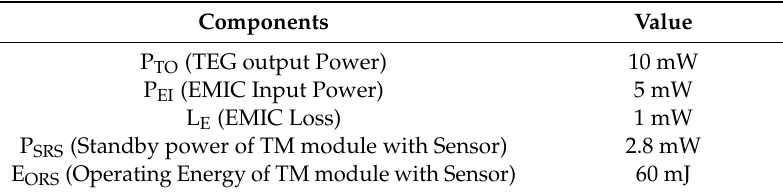
Table 4. I / O power and power consumption of each